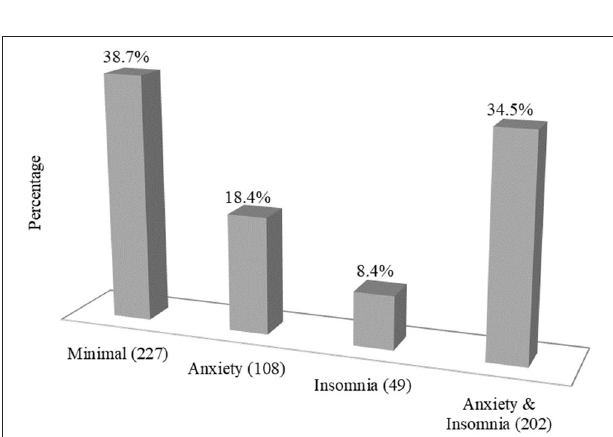
FIGURE 2 | Overall prevalence of anxiety and insomnia among the urban slum